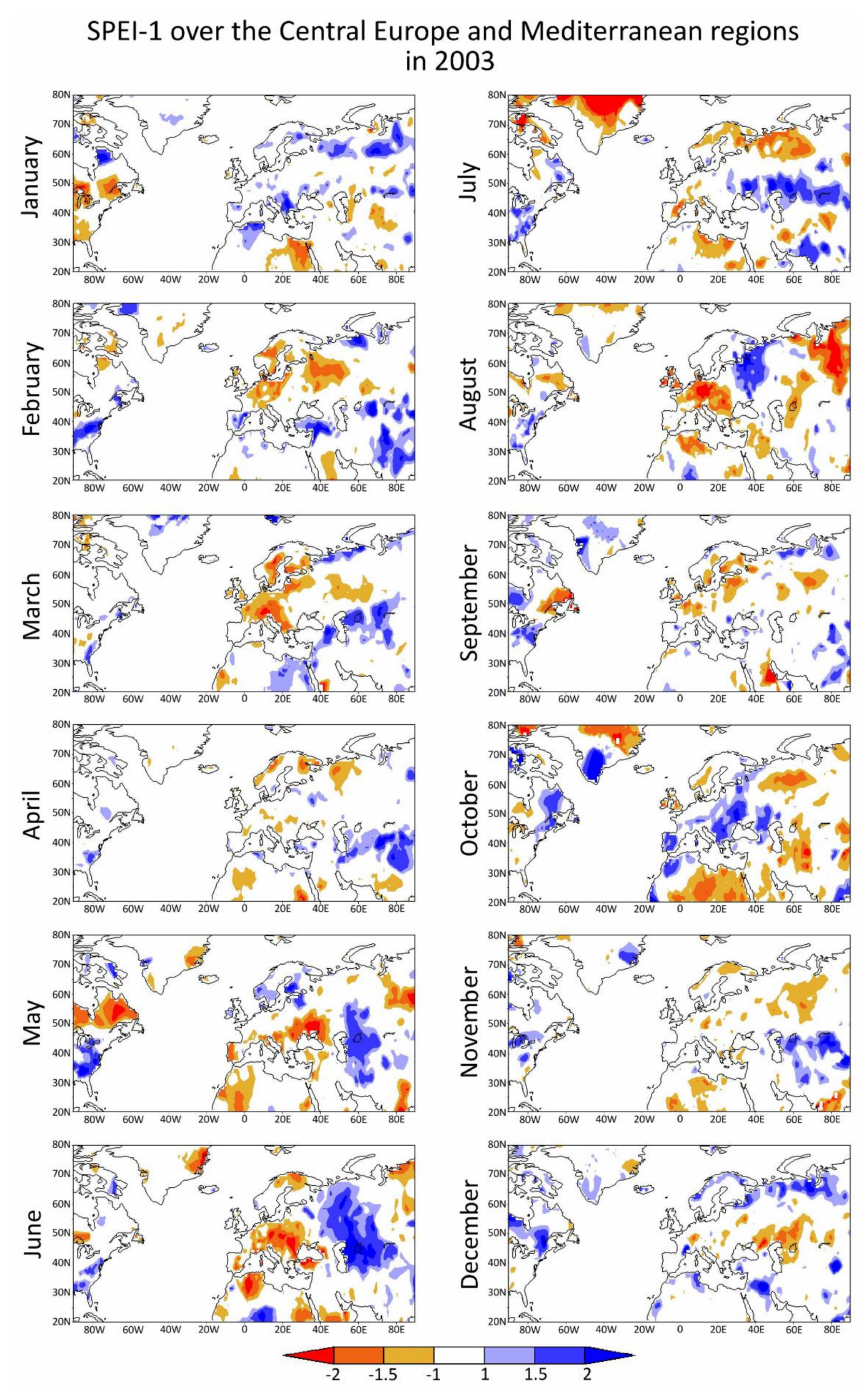
Figure 5. SPEI-1 values in 2003 over the European